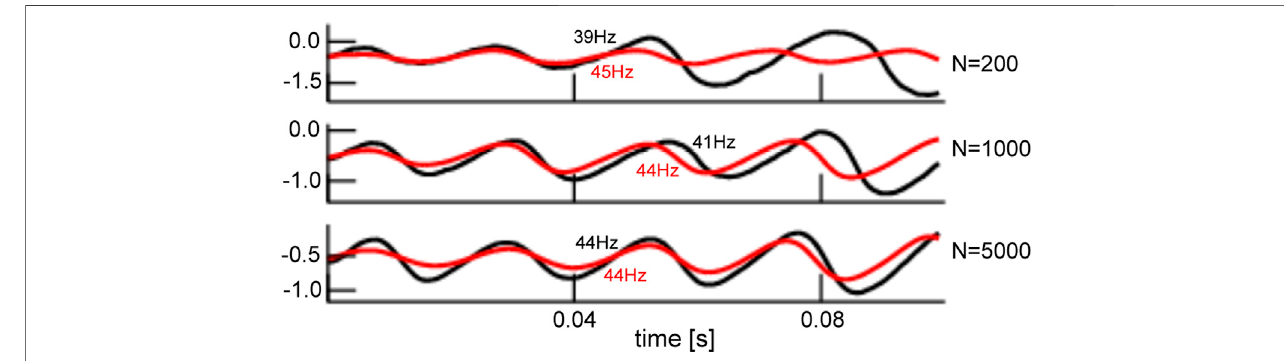
FIGURE 8 | Comparison of network average and mean- fi eld solution for different network sizes. The network average (black) and mean- fi eld solutions (red) resemblesmoreandmorethelargerthenetworkofsize N .Thisholdsforthemagnitudeandfrequency(providedinpanels)ofbothsolutions.Theinitialvalueofthemean- fi eld activity has been chosen to the initial value of the network average. Simulations consider zero-mean Gaussian simulations with q (cid:1) 1 and D